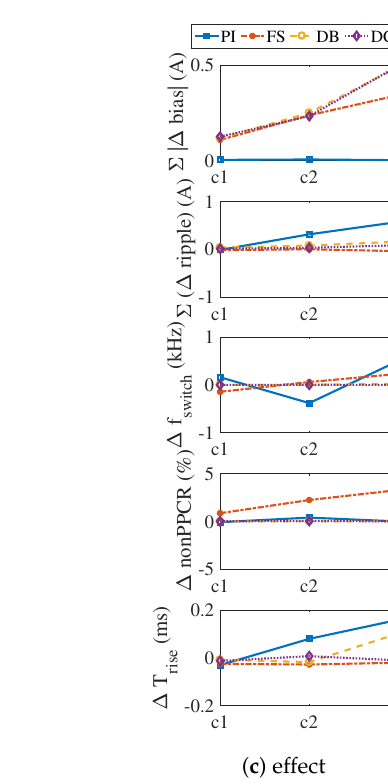
Figure 15. Measured effect of DC-bus voltage V dc and mechanical speed N on the KPIs with a healthy rotor. Three working conditions are tested: (c1) V dc = 70 V, N = 200 rpm, (c2) V dc = 120 V, N = 400 rpm, (c3) V dc = 200 V, N = 800